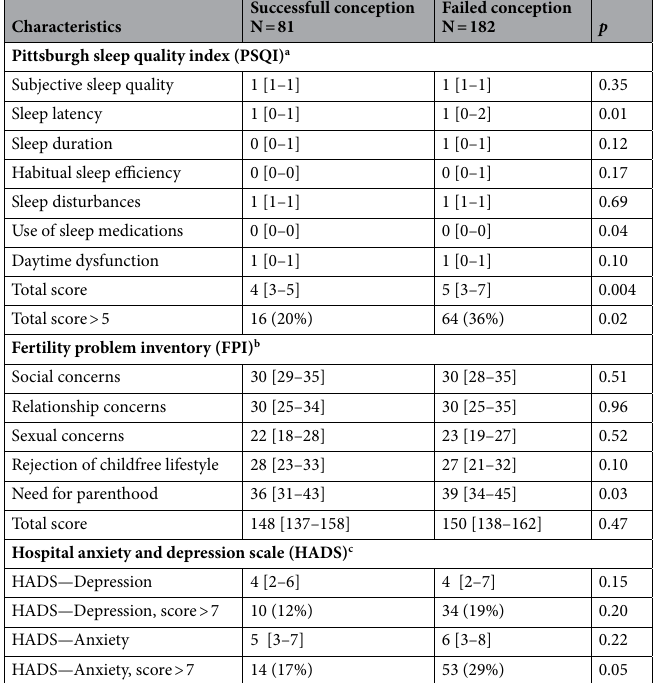
Table 3. Sleep quality, anxiety and depression scores in women who did and did not achieve a pregnancy. Data is reported as number (%) or Median [interquartile range], as appropriate. a Data is available for 79 pregnant women and 180 not pregnant women. b Data is available for 79 pregnant women and 176 not pregnant women. c Data is available for 81 pregnant women and 182 not pregnant